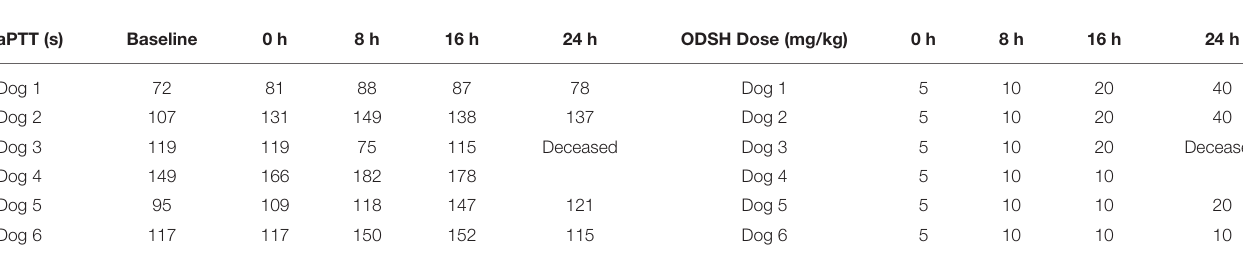
TABLE 2 | Activated partial thromboplastin time measured and ODSH dose administered at baseline and each study time